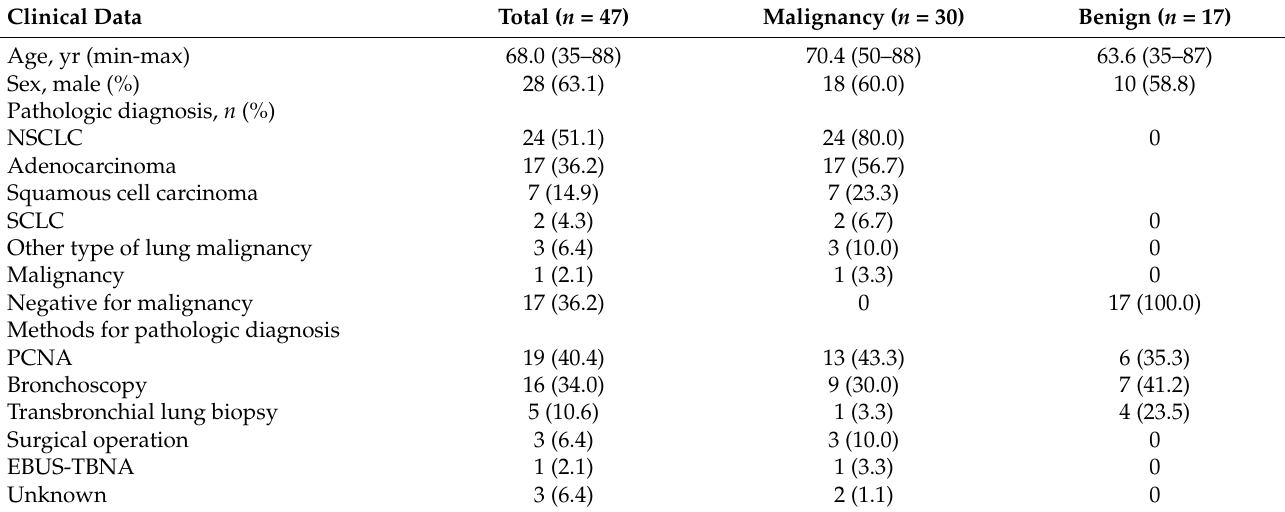
Table A3. HSHH clinical data.